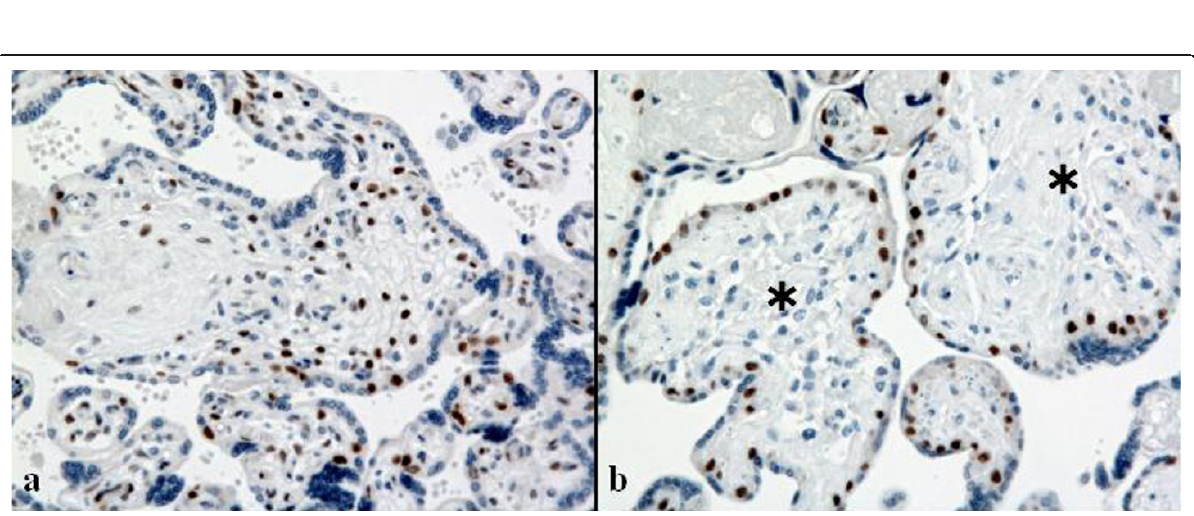
Figure 6 Androgenetic/biparental mosaicism detected by p57 kip2 immunohistochemical staining in the affected lesion . p57 kip2 -positive stromal cells indicate biparental villi in a, and no p57 kip2 -positive stromal cell in some villi (asterisks) suggests androgenetic villi in b. (objective ×10).